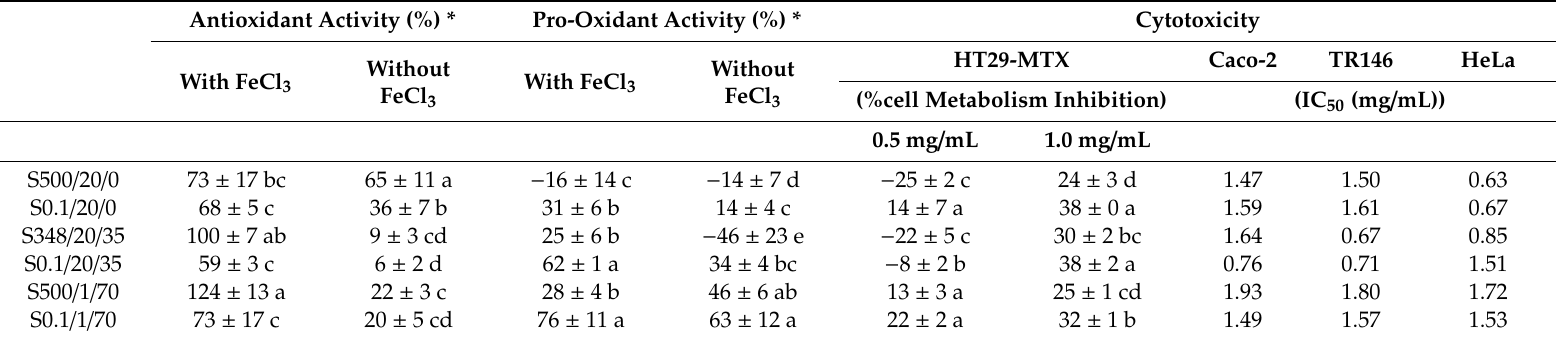
Table 4. Results for DNA extraction, degradation (expressed in percentage of DNA degradation inhibition for antioxidant activity and percentage of DNA degradation for pro-oxidant activity) and cytotoxicity (expressed in percentage of cell metabolism inhibition for HT29-MTX; and in IC 50 (mg / mL) for Caco-2, TR146, and HeLa cell lines). Di ff erent letters indicate significant di ff erences ( p < 0.05) between extracts for each assay (analysis by